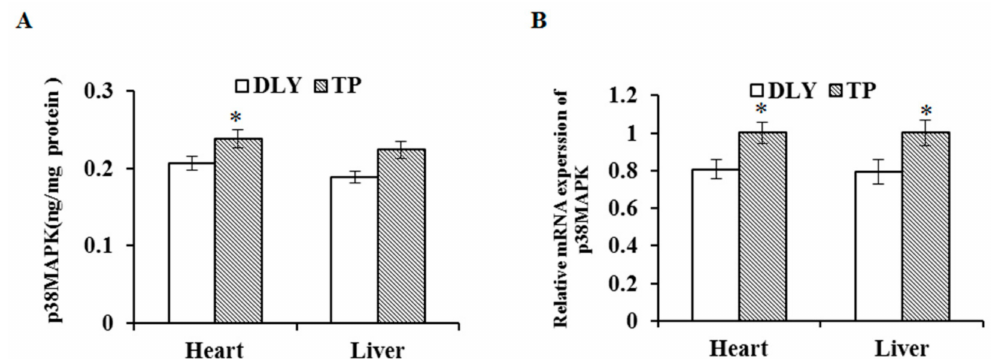
Figure 5. Effects of the plateau environment on protein ( A ) and mRNA ( B ) expression levels of p38 MAPK in heart and liver of TPs and DLY pigs ( n = 12). * Significant difference ( p < 0.05). p38 MAPK = p38 mitogen-activated protein kinase.